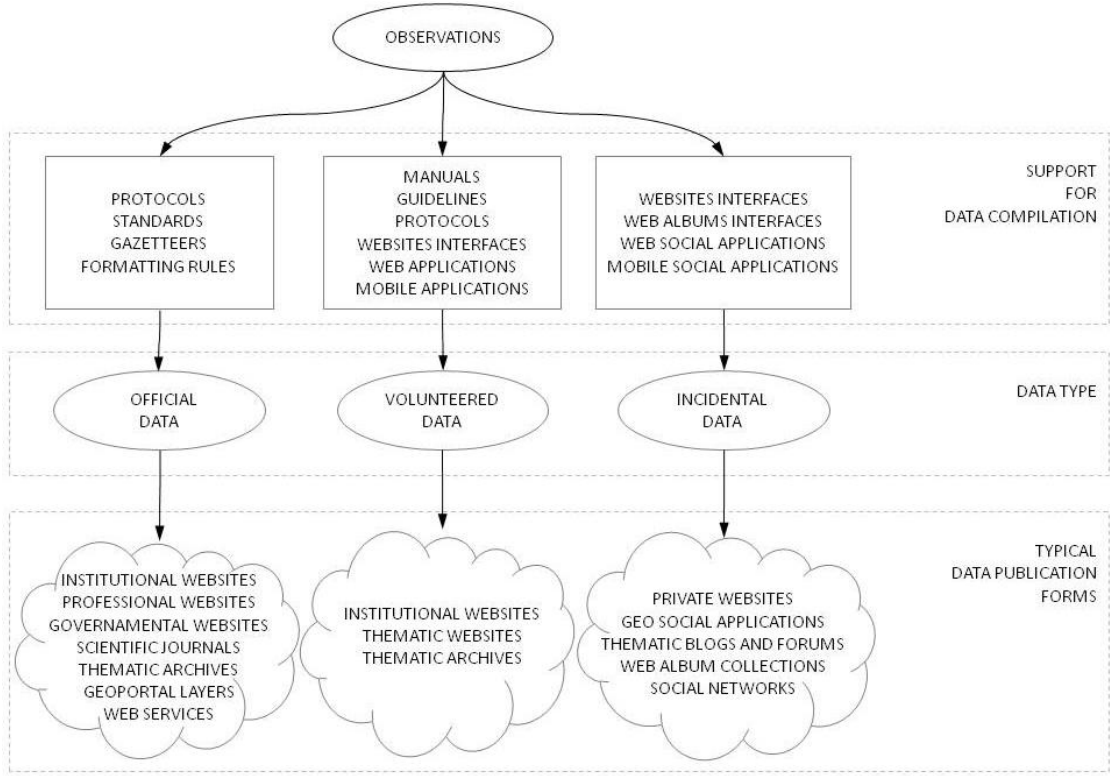
Figure 2. Synthetic representation of workflows for official, volunteered and incidental